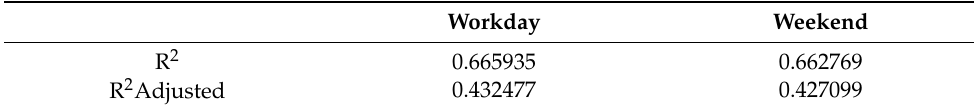
Table 5. Comparison of the degree of explanation.